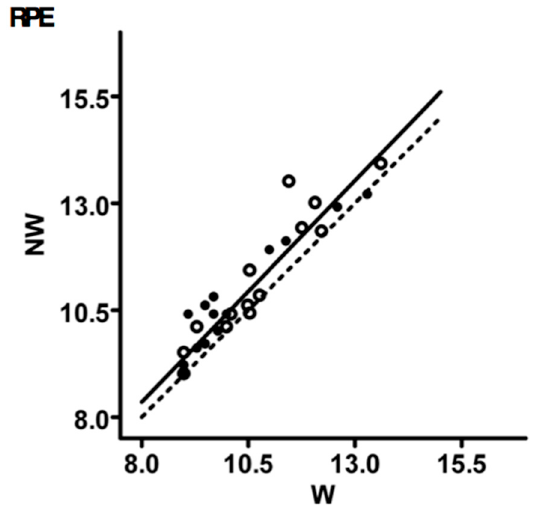
Figure 5. Perceived Exertion Intensity The regression line was slightly but not significantly above the 1:1 correspondence line. The grand mean (mean of the means) of RPE was not different in NW compared to W (10.7 ± 1.5 in NW and 10.3 ± 1.3 in W). NW: dashed line and empty circles; W: continuous line and solid circles.